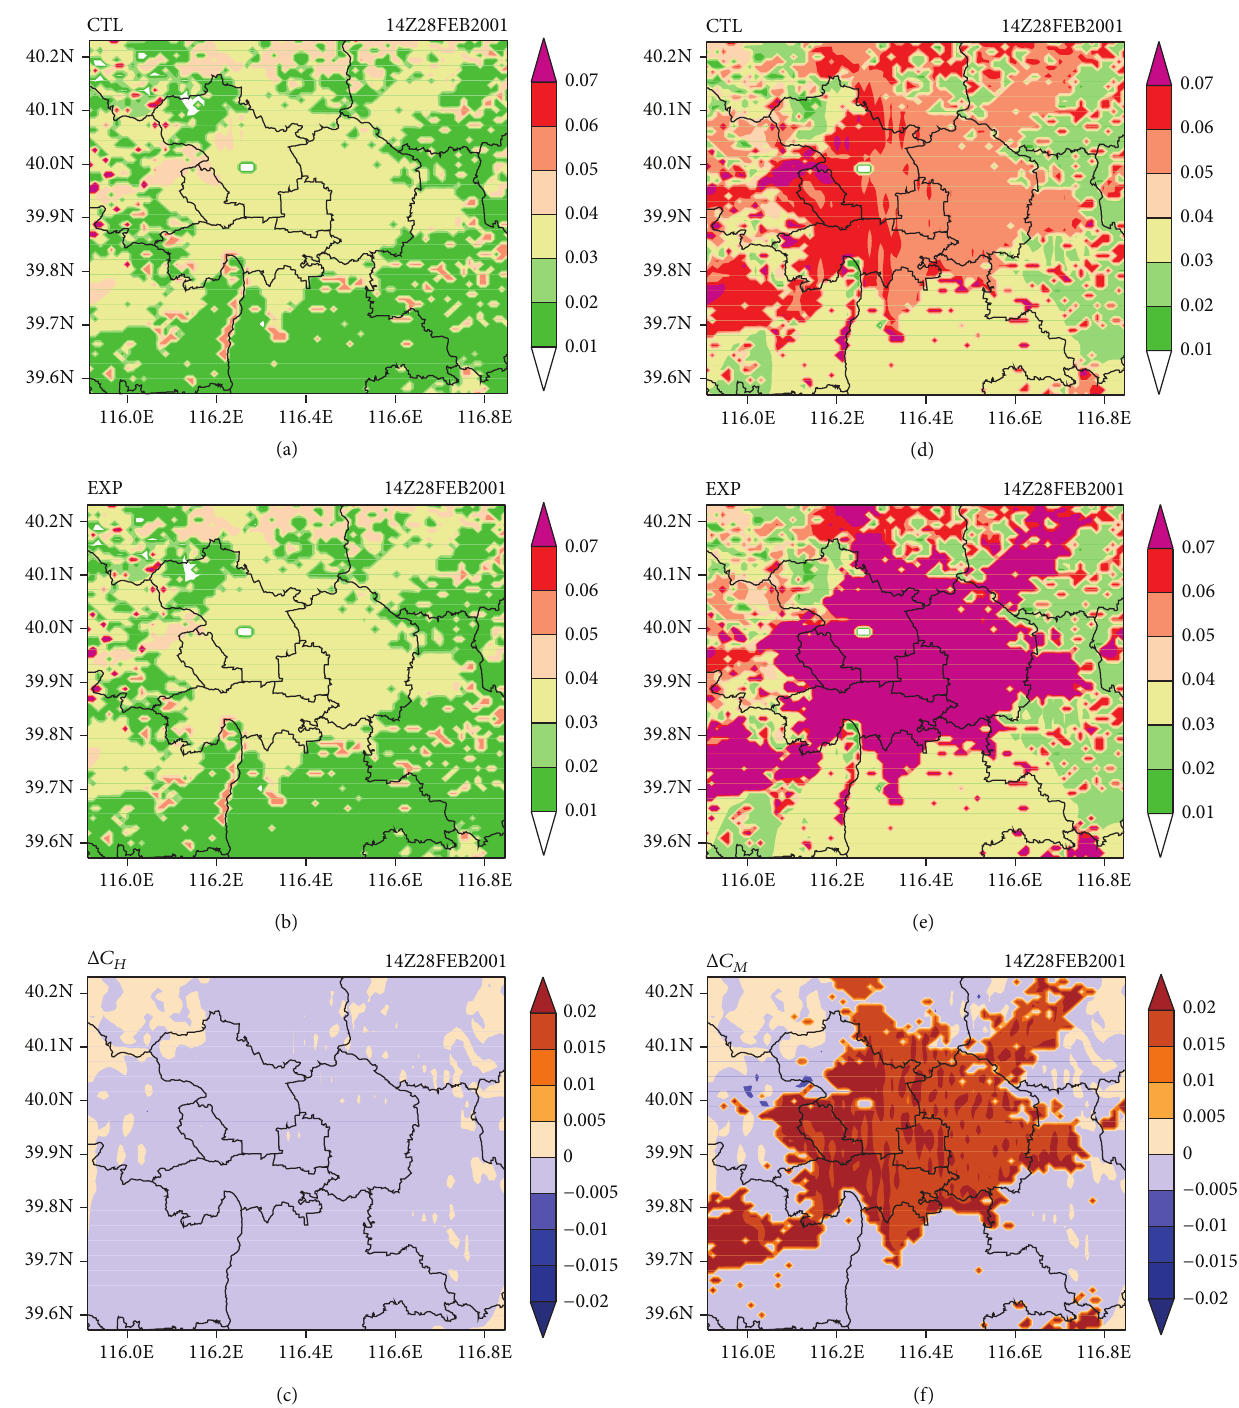
Figure 8: The momentum bulk transfer coefficient ( 𝐶 𝑀 ) and heat bulk transfer coefficient ( 𝐶 𝐻 ) simulated by the CTL run and the EXP run at 0200 LST 28 February 2001 and their differences: (a) 𝐶 𝐻 from the CTL run, (b) 𝐶 𝐻 from the EXP run, (c) 𝐶 𝐻 differences between the EXP run and the CTL run, (d) 𝐶 𝑀 from the CTL run, (e) 𝐶 𝑀 from the EXP run, and (f) 𝐶 𝑀 differences between the EXP run and the CTL